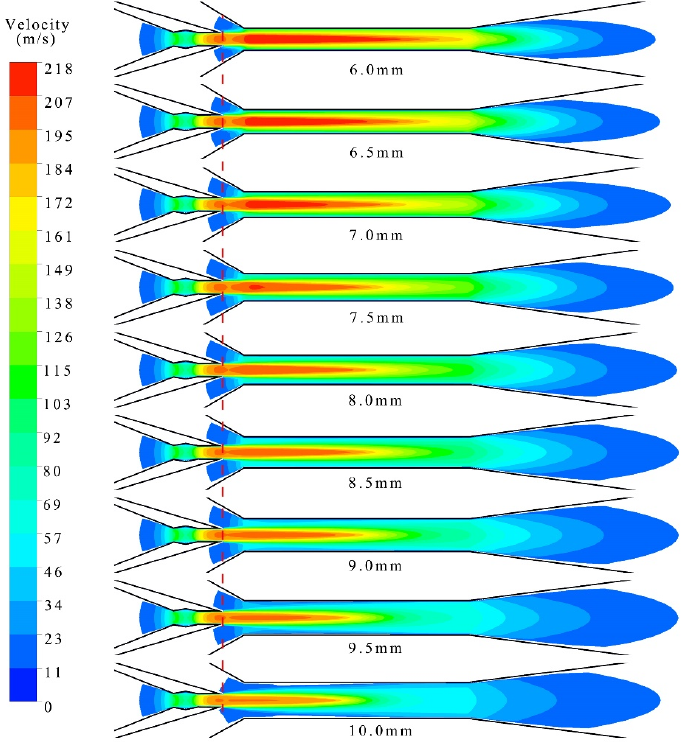
Figure 9. Fields of velocity under different D m ( P p of 9.3 MPa).